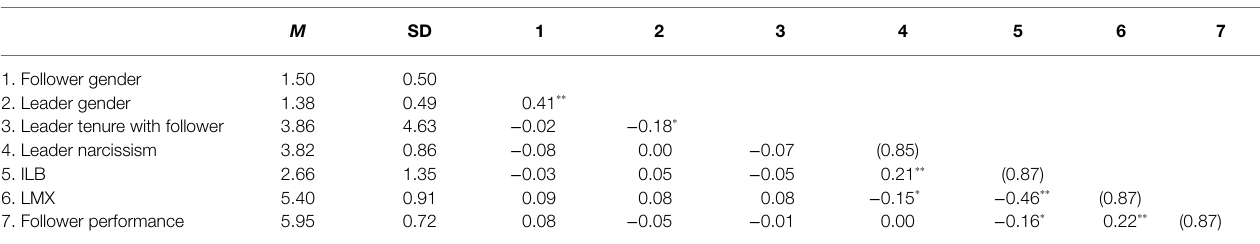
TABLE 2 | Means, standard deviations, and correlations (Cronbach Alphas on diagonal). M SD